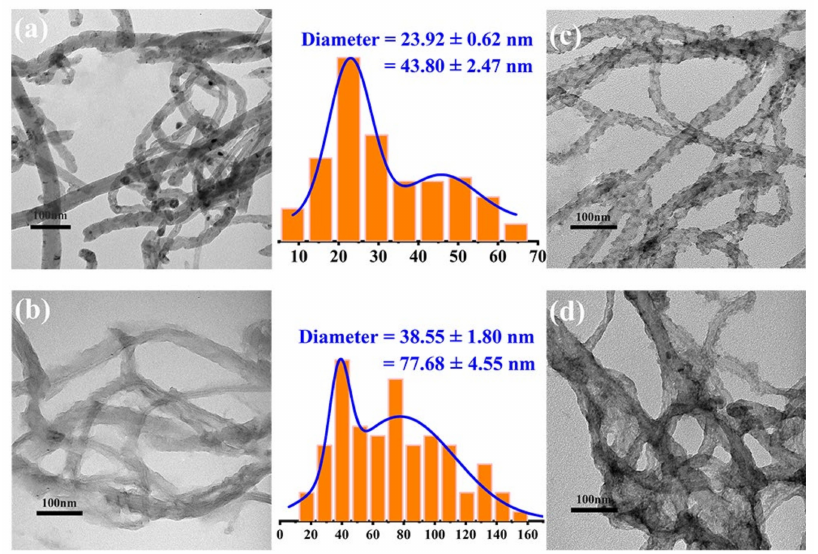
Figure 1. TEM images and average diameter distribution histograms of ( a ) MWCNTs, ( b ) uMWCNTs, ( c ) ETP-MWCNTs, ( d )